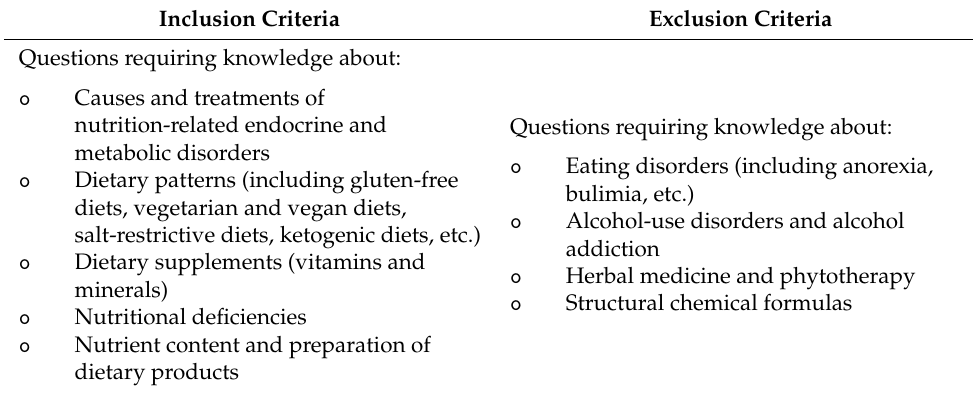
Table 1. Question inclusion and exclusion criteria. Suitability for inclusion of the screened multiple- choice questions was evaluated based on the displayed in- and exclusion